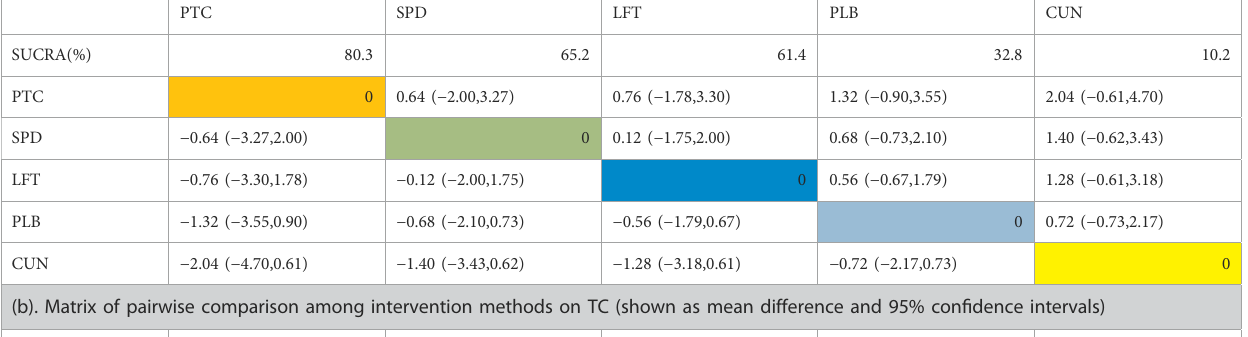
(b). Matrix of pairwise comparison among intervention methods on TC (shown as mean difference and 95% con fi dence intervals)